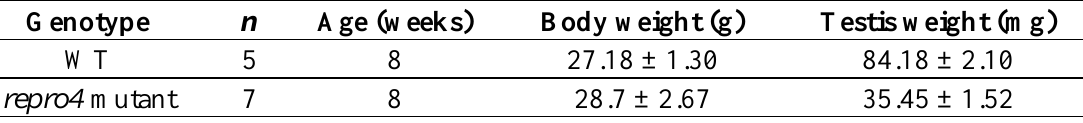
Table 1. Mean testis weights of WT and repro4 mutant